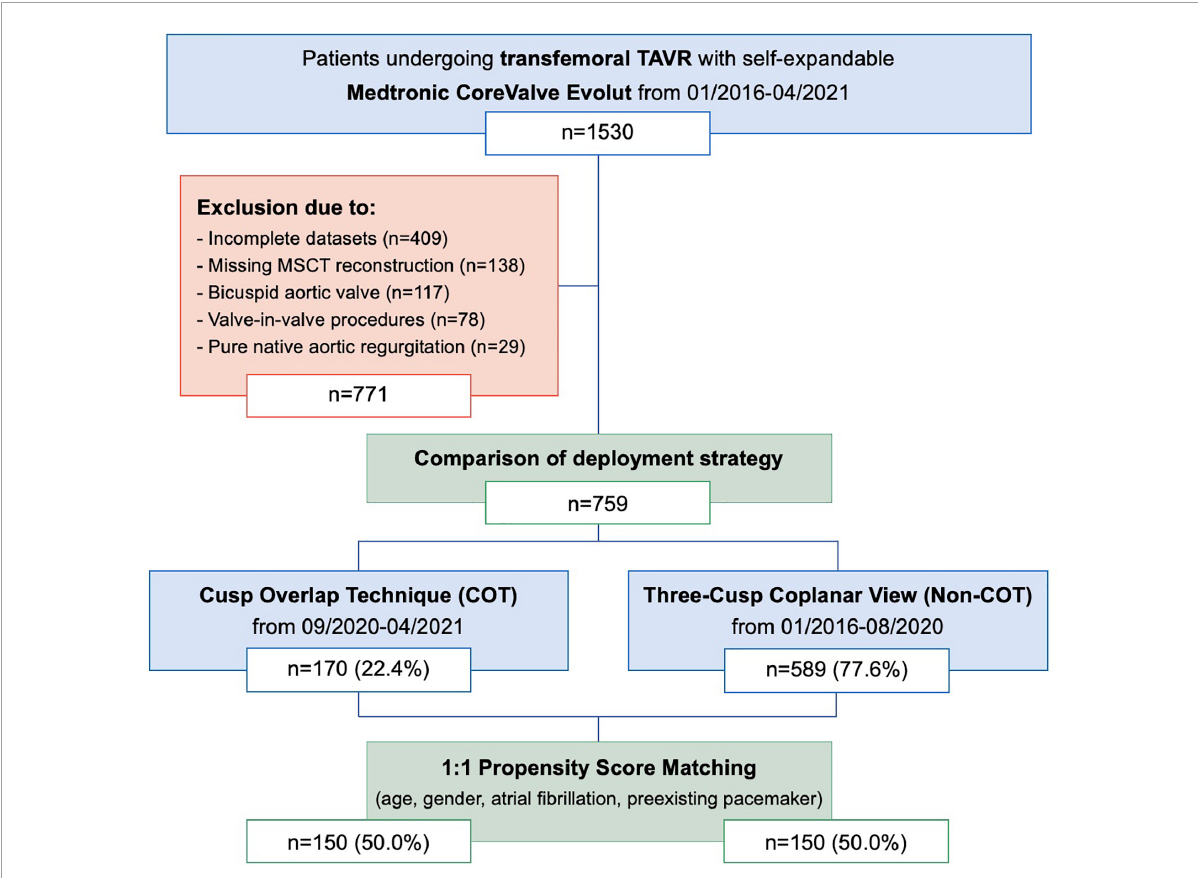
FIGURE1 Modified CONSORT Diagram. From January 2016 to April 2021, a total of 1,530 patients underwent TAVR with the Medtronic CoreValve Evolut at the Heart Center Düsseldorf. A total of 759 patients were included in the comparison of the deployment strategy. A total of 1:1 propensity score matches analysis resulted in the final study cohort of 150 COT patients and 150 Non-COT patients. COT, cusp-overlap technique; MSCT, multislice computed tomography; TAVR, transcatheter aortic valve